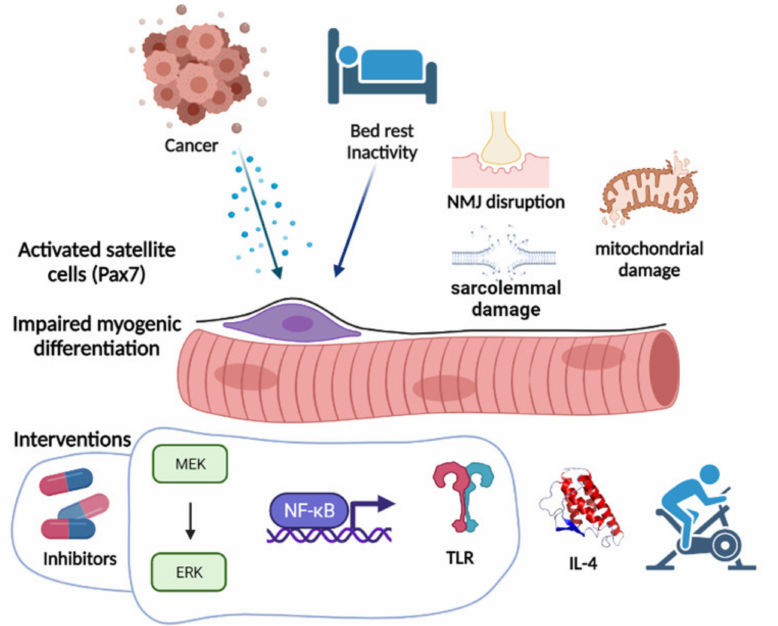
Figure 2. Cancer and the consequent inactivity impair the myogenic process, either directly via cytokine release or through several mechanisms including neuromuscular junction (NMJ) disruption, and mitochondrial and sarcolemmal damage. Several interventions have been proposed, mainly focused on signaling pathway inhibition, cytokine modulation, and exercise or exercise-mimicking metabolism modulators. Image created with BioRender.com (accessed on 17 August